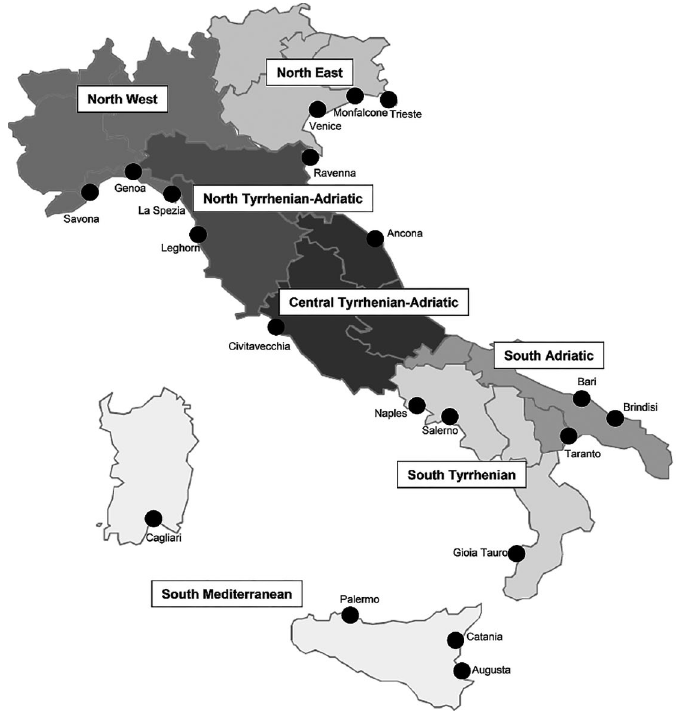
Fig. 1. Italian macro-regions and